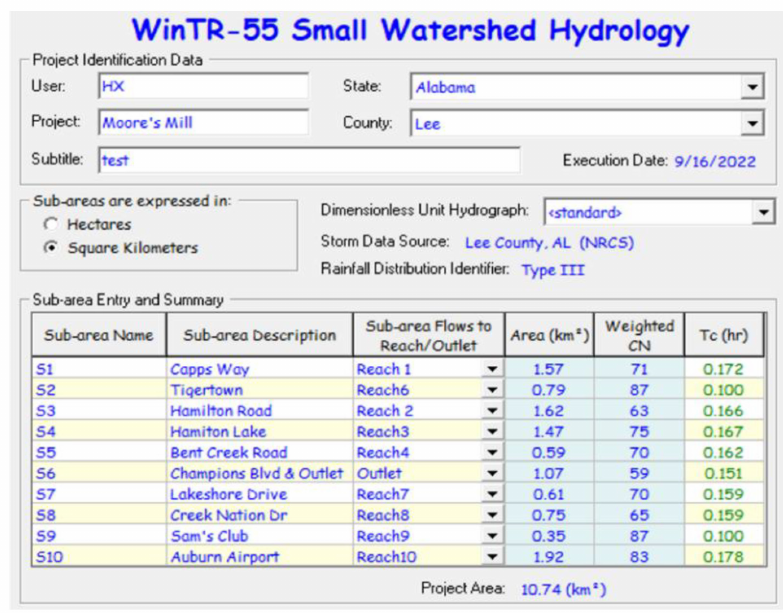
Figure 7. WinTR-55 screen with the data for the modeling of Moore’s Mill Creek watershed.